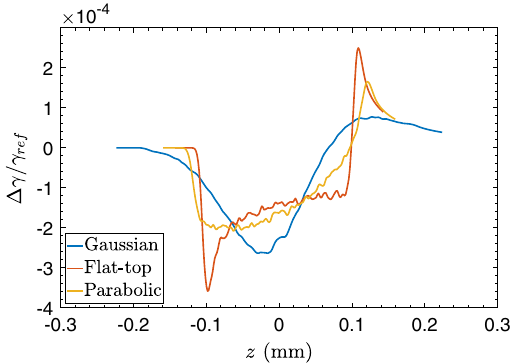
FIG. 14. Energy change induced by the CSR effect with several beam distributions. Only the steady-state mode was turned on. The beam head is located at positive z , whereas the tail is at negative z .